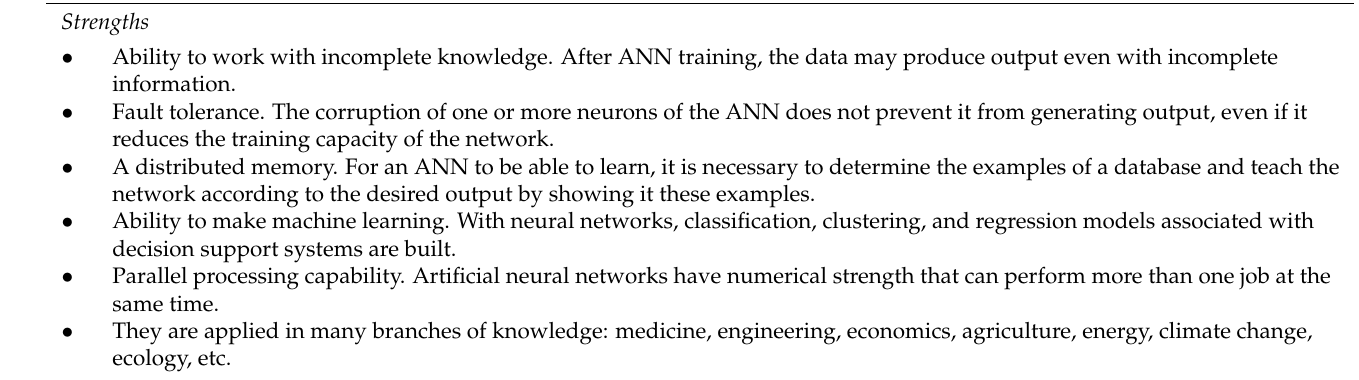
Table 1. Main strengths and weaknesses of neural networks as a classification method based on artificial intelligence. Artificial Neural Networks. Strengths and